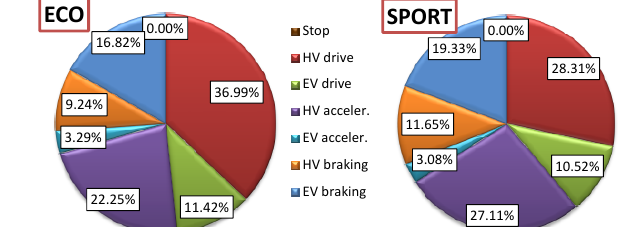
Fig. 6. The percentage share of individual driving modes in relation to distance traveled during the